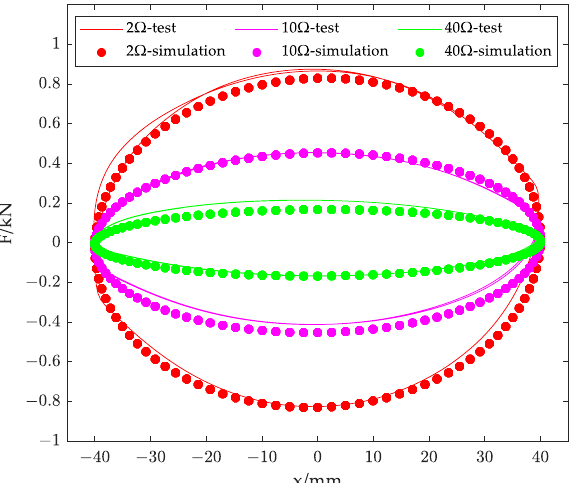
Figure 8. Test and simulation damping characteristics response results.